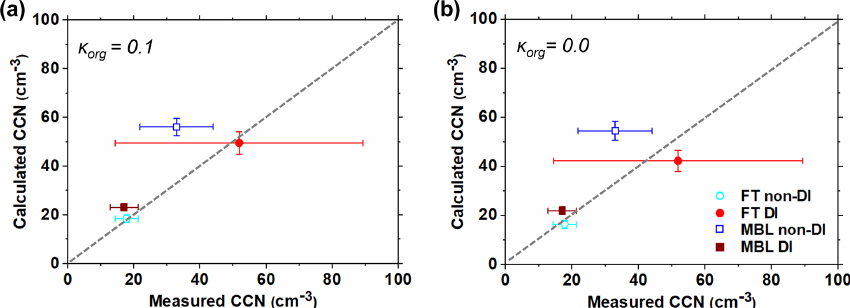
Figure 7. Comparison of the CCN concentration predicted from the particle size distribution and OVF with field-measured CCN by onboard instruments across the different atmospheric layer and transport event. (a) κ org = 0 . 1; (b) κ org = 0 . 0. The gray dashed line corresponds to the 1 : 1 calculated CCN to measured